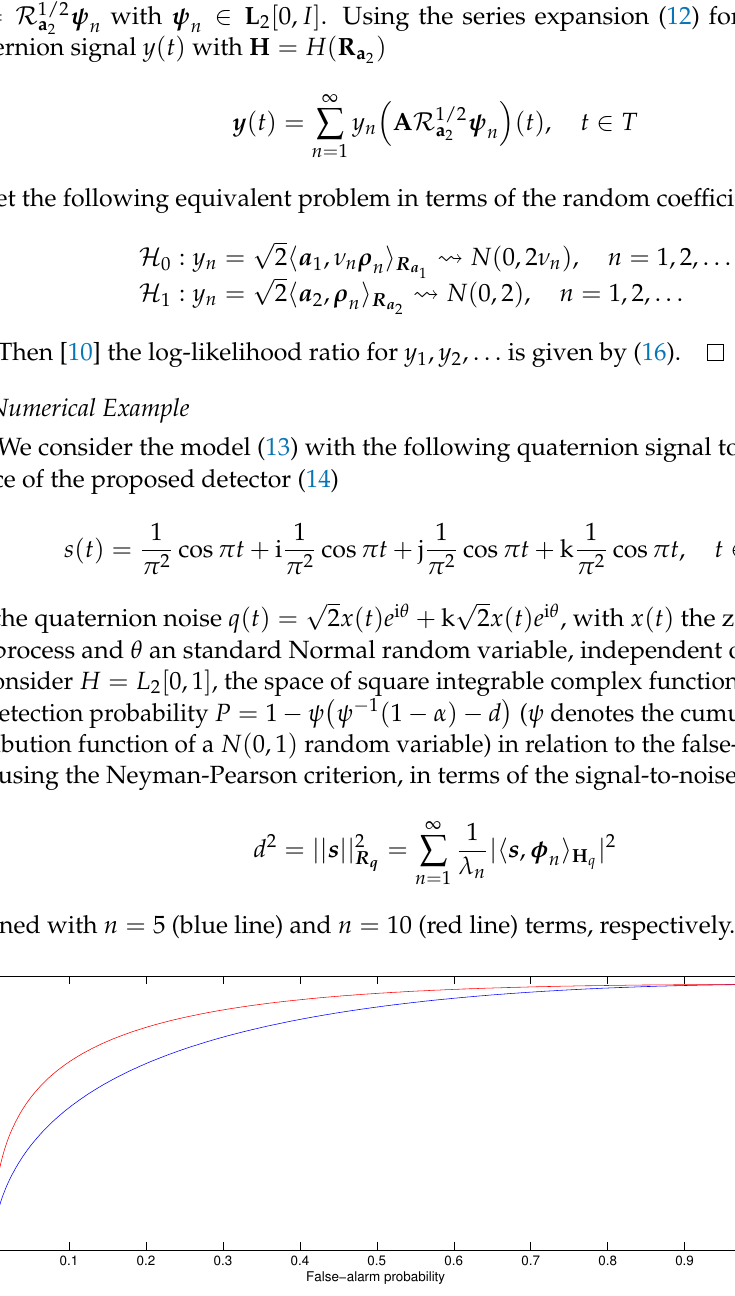
Figure 1. Detection probability versus the false-alarm